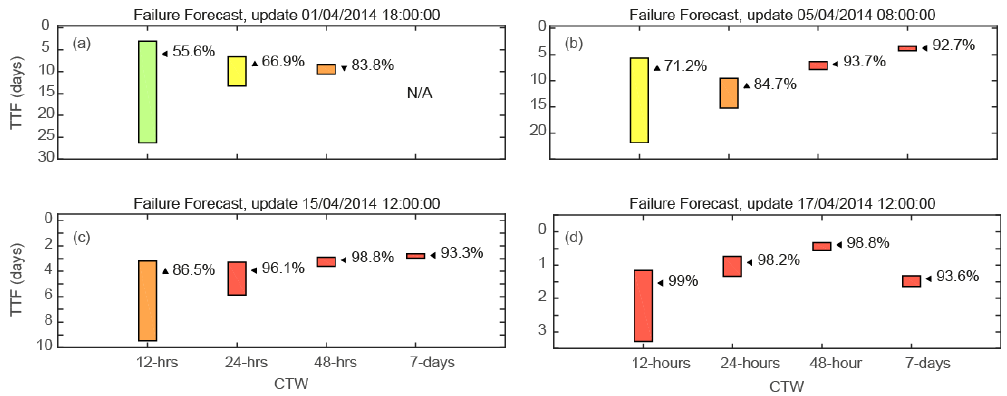
Figure 4. Results of the failure forecast procedure obtained in near real time during the 2014 emergency scenario. Note how the TTF predicted varies depending on the CTW